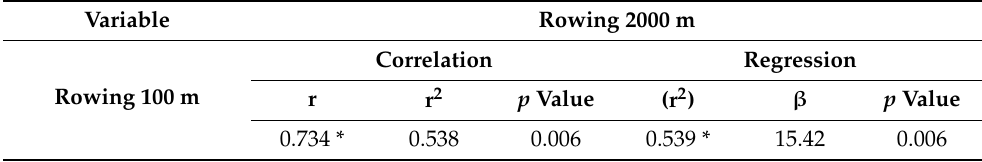
Table 2. Correlations and regressions of variables with a performance at different distances in rowing.